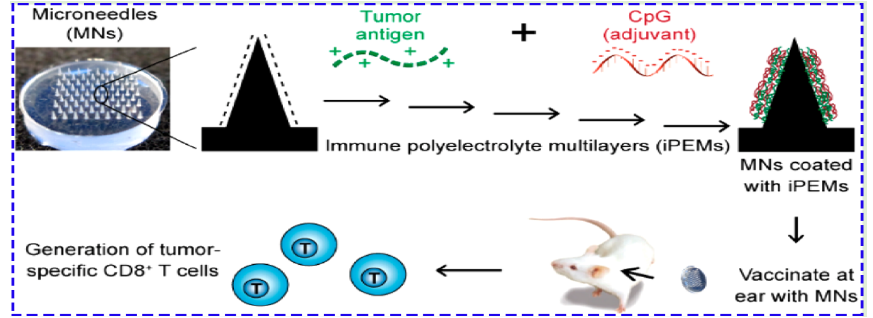
Figure 3. Assembly method for immune polyelectrolyte multilayers on microneedle arrays to enhance cancer vaccination. Reprinted with permission from [102]. Immune polyelectrolyte multilayers (iPEM), cytosine triphosphate deoxynucleotide guanine triphosphate deoxynucleotide (CpG)